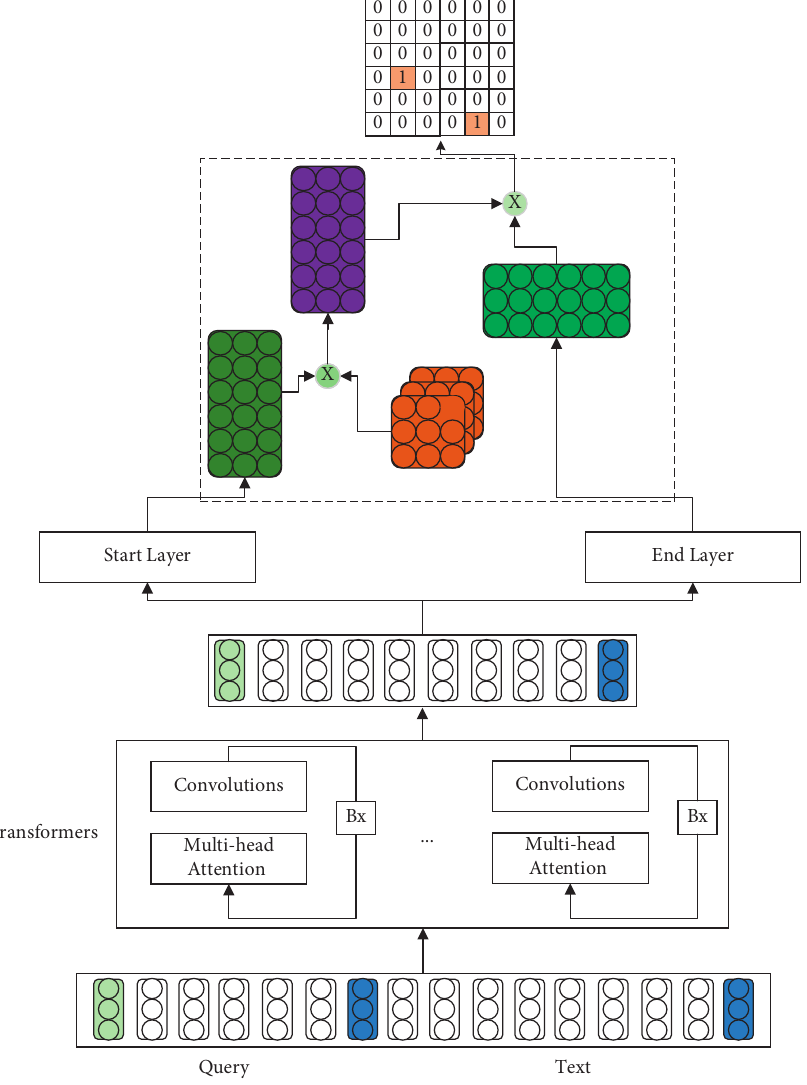
Figure 1: The network architectures of our